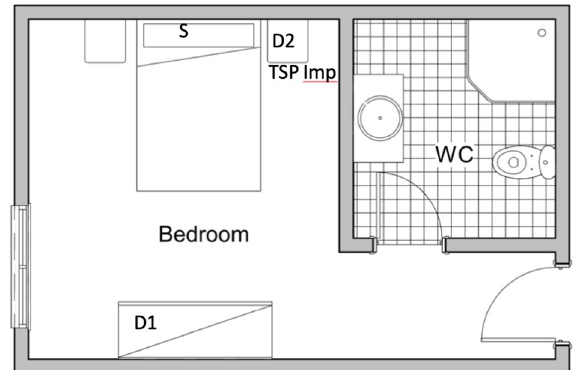
Figure 1. Schematic top view illustration of the rooms plants and representative sampling sites, similar over the 4 nursing rooms (AA, BB, CC and DD). D1, D2 Deposition samples sites, S surface samples, TSP total suspended particles, Imp. impactor air